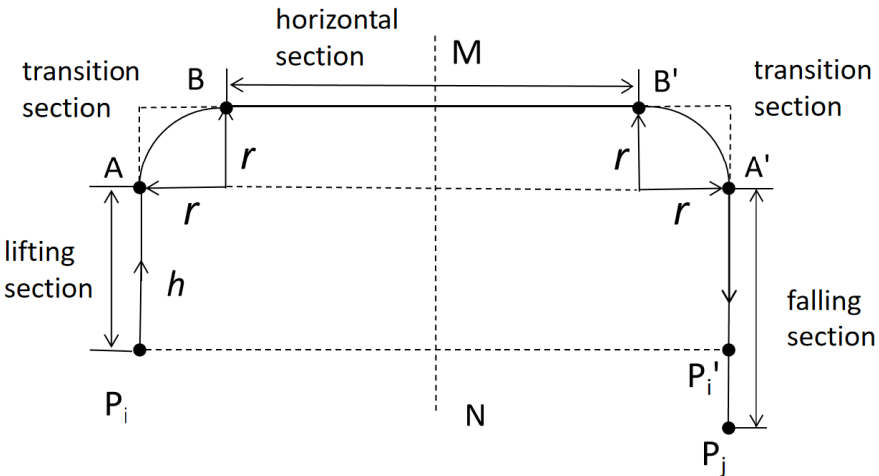
Figure 7. The fixed height ∩ -shaped track model.